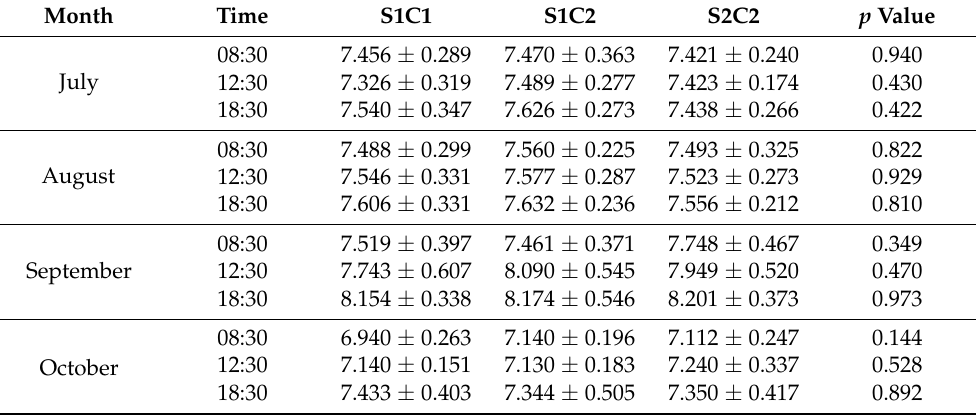
Table 1. Monthly variation of water pH in different